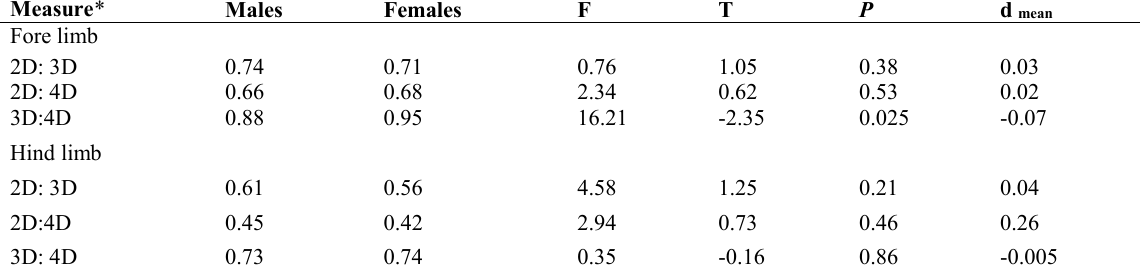
Table 1. Summary of sex differences in left fore and hind limb in D. cholorogaster Measure*